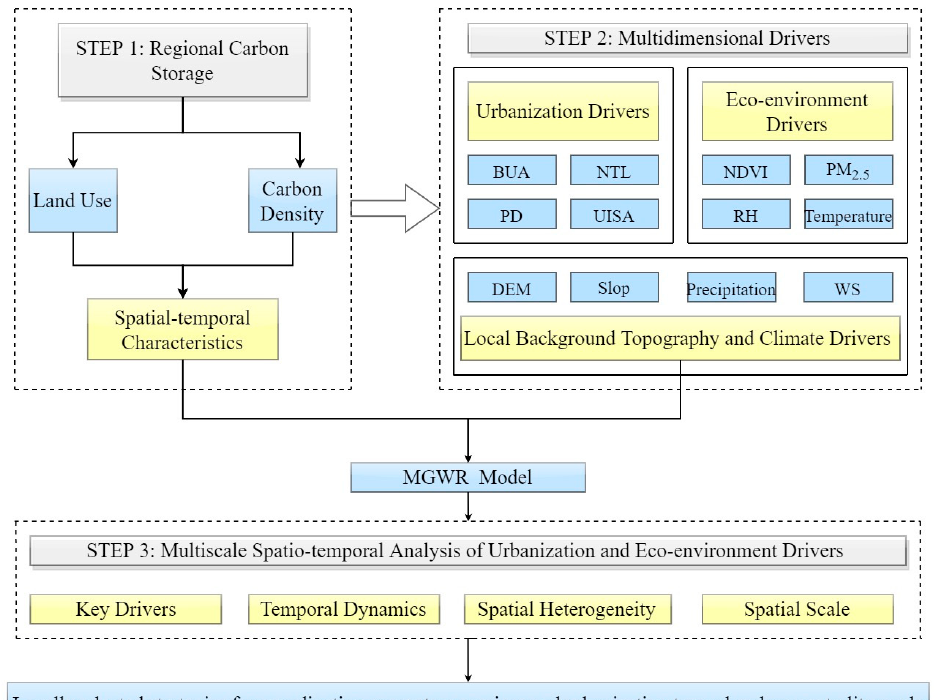
Figure 1. Research framework for multiscale spatio-temporal analysis. Please see Table S1 for an explanation of each abbreviation used in this figure.